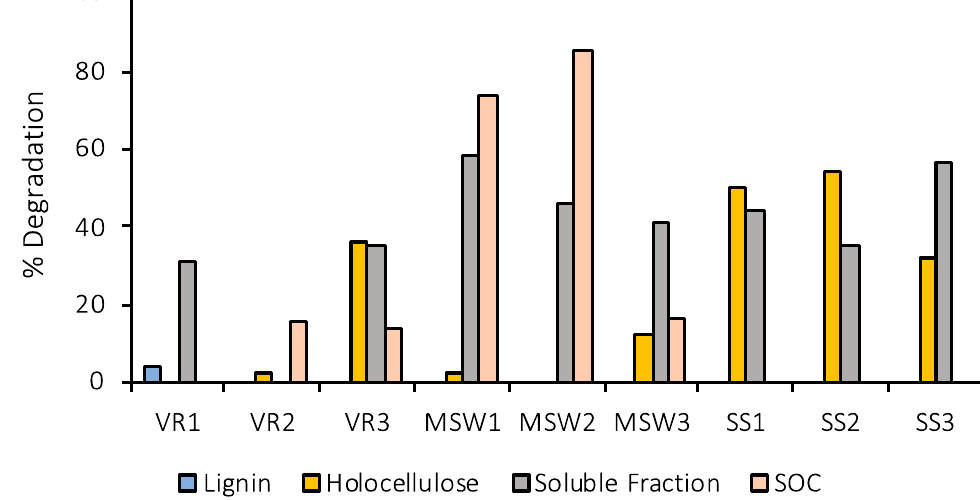
Figure 2. Percentage of degradation in organic fractions during industrial composting processes. Abbreviations: vegetal residue (VR); municipal solid waste (MSW); sewage sludge (SS); holocellulose (cellulose + hemicellulose); soluble fraction (include reducing sugars, total proteins, N-NO 3 − and N-NH 4+ ); Soluble Organic Carbon (SOC).